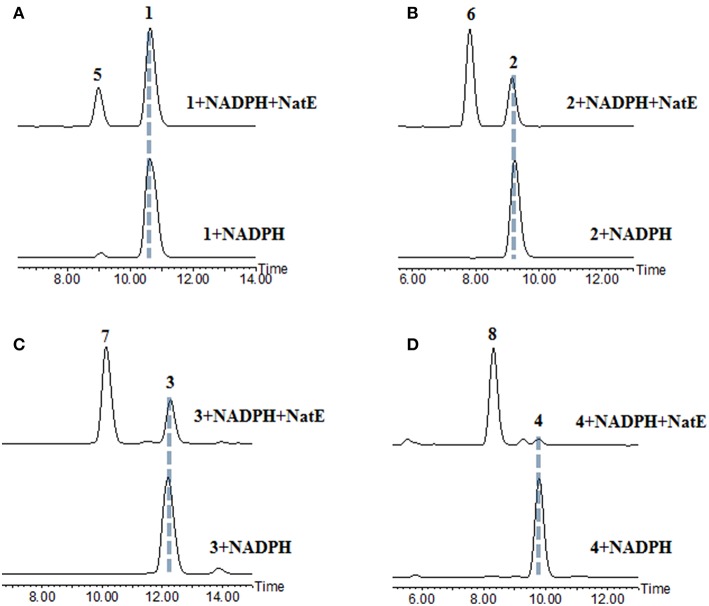
HPLC analysis of the products generated in the NatE enzymatic conversion. The LC-MS data are displayed with total ion current. (A) 1 was converted to 5. (B) 2 was converted to 6. (C) 3 was converted to 7. (D) 4 was converted to 8.